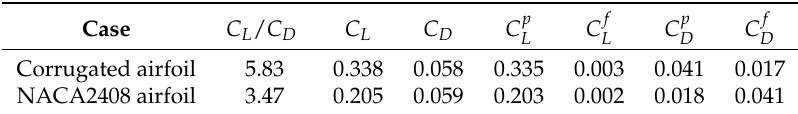
Table 3. The lift and drag coefficients of a corrugated airfoil at angle of attack of 2 ◦ , Re = 4000 and its